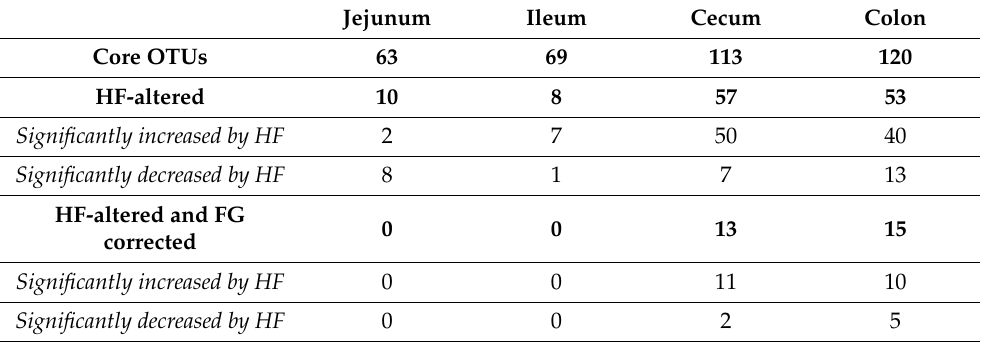
Figure 6. Relative abundance of operational taxonomic units (OTU) determined by 16S sequencing and grouped by phyla, showing an increase in Verrucomicrobia with the addition of FG to either CD or HF diets. The relative abundances are shown for each diet individually for each intestinal region analyzed. Table 3. Summary of OTUs from each analyzed intestinal region in this study. OTUs which were present in all dietary groups were labeled as core OTUs. HF-altered FG-corrected OTUs were determined by log 2 fold changes as determined from pairwise comparisons using DESeq2. p -values were adjusted using a Benjamini–Hochberg correction, and a threshold of p adj < 0.05 was used for each comparison. Specific OTUs, log 2 fold changes, and adjusted p -values can be found in Supplementary Tables